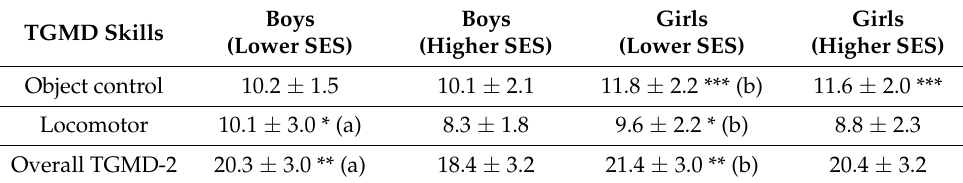
Table 5. TGMD-2 performance considering SES and sex of